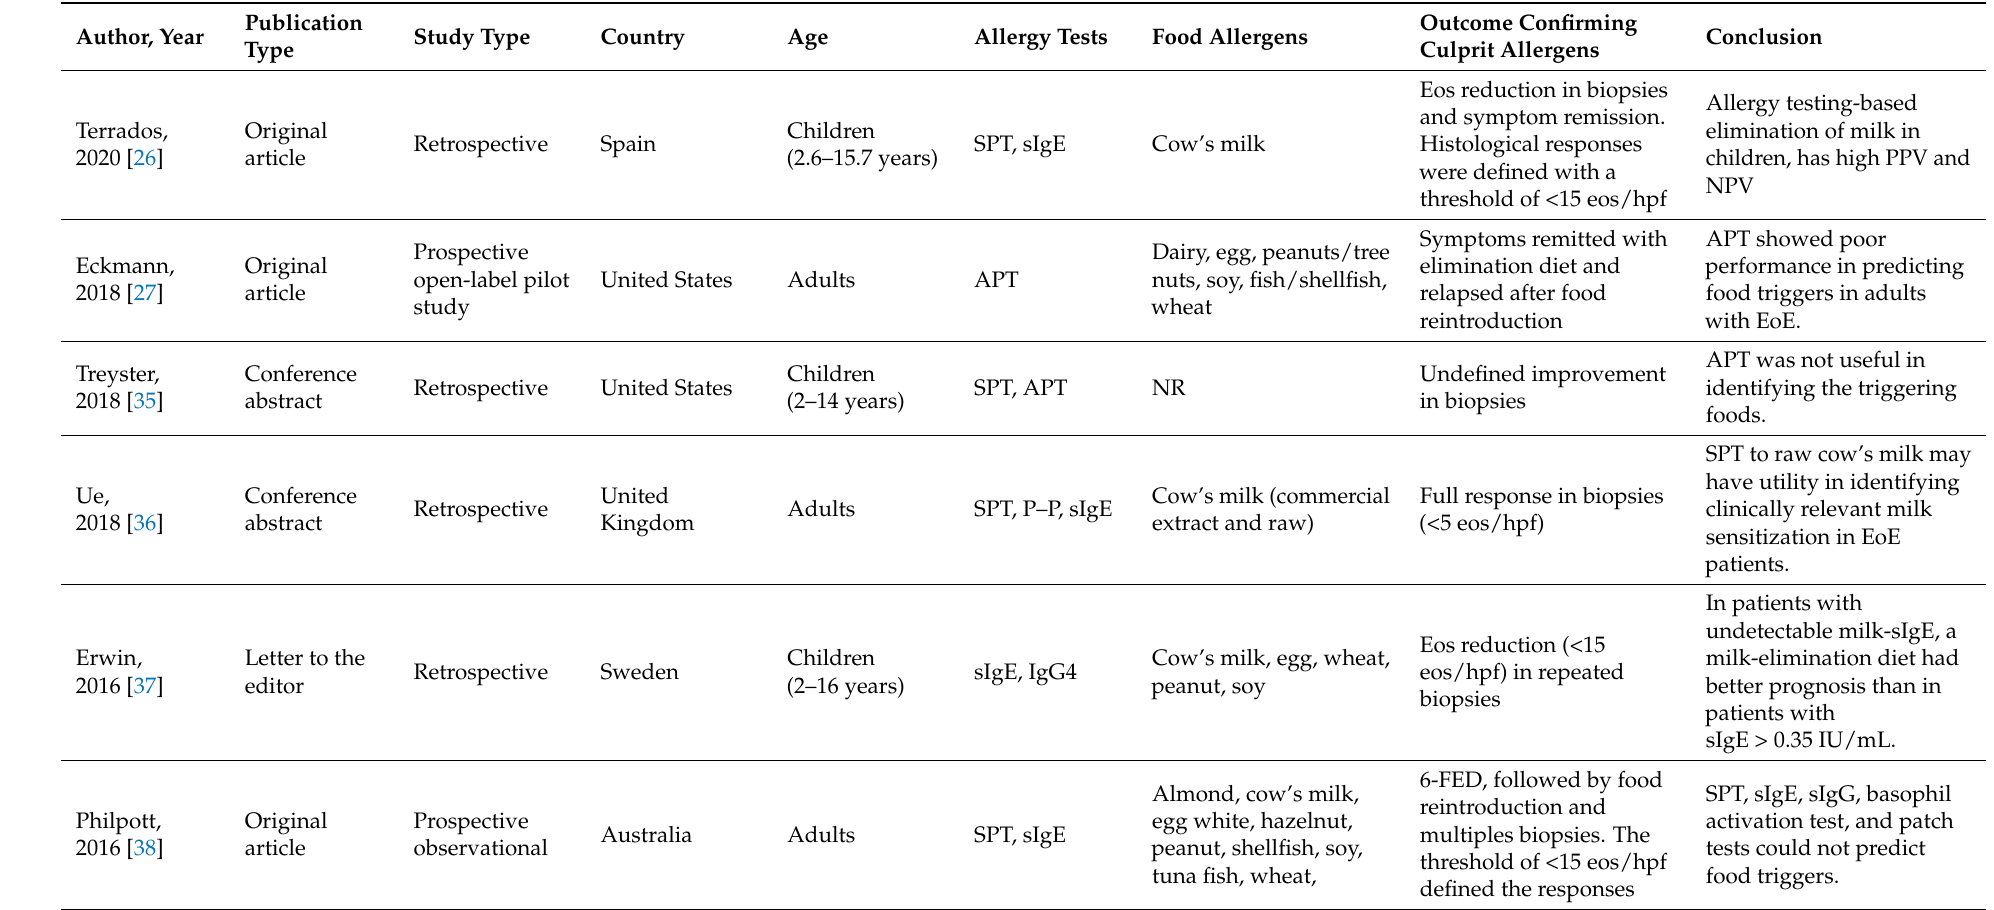
Table 1. Studies included in the systematic